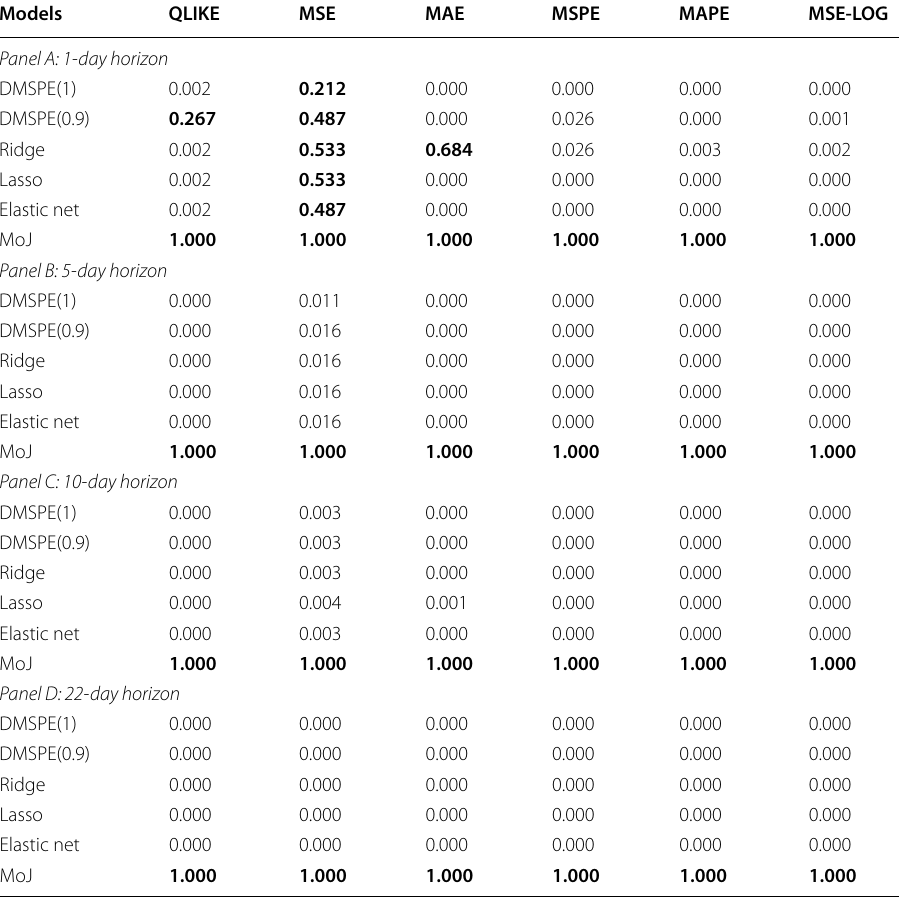
Table 13 A comparison of alternative forecasting